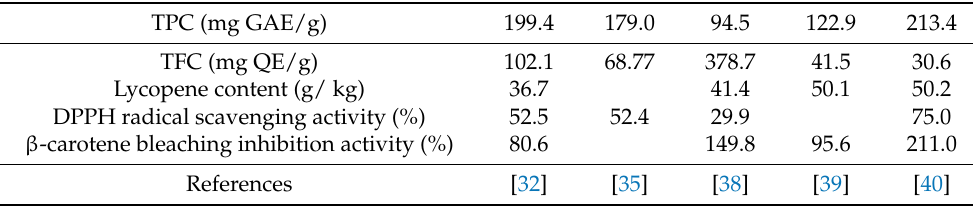
Table 2. The antioxidant content of tomato pomace (g/kg dry matter basis).